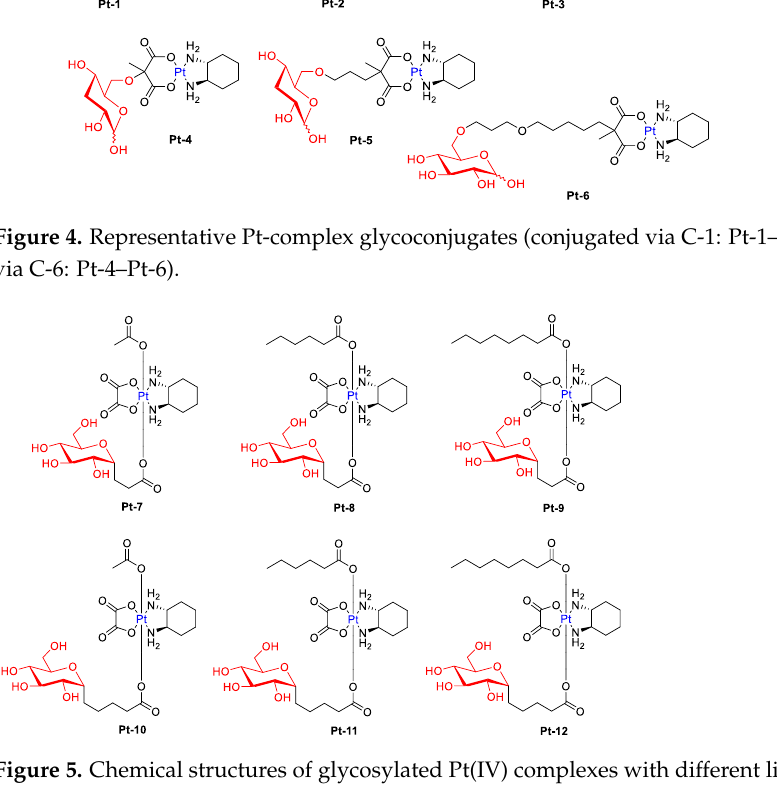
Figure 4. Representative Pt-complex glycoconjugates (conjugated via C-1: Pt-1 – Pt-3 and conjugated via C-6: Pt-4 – Pt-6).